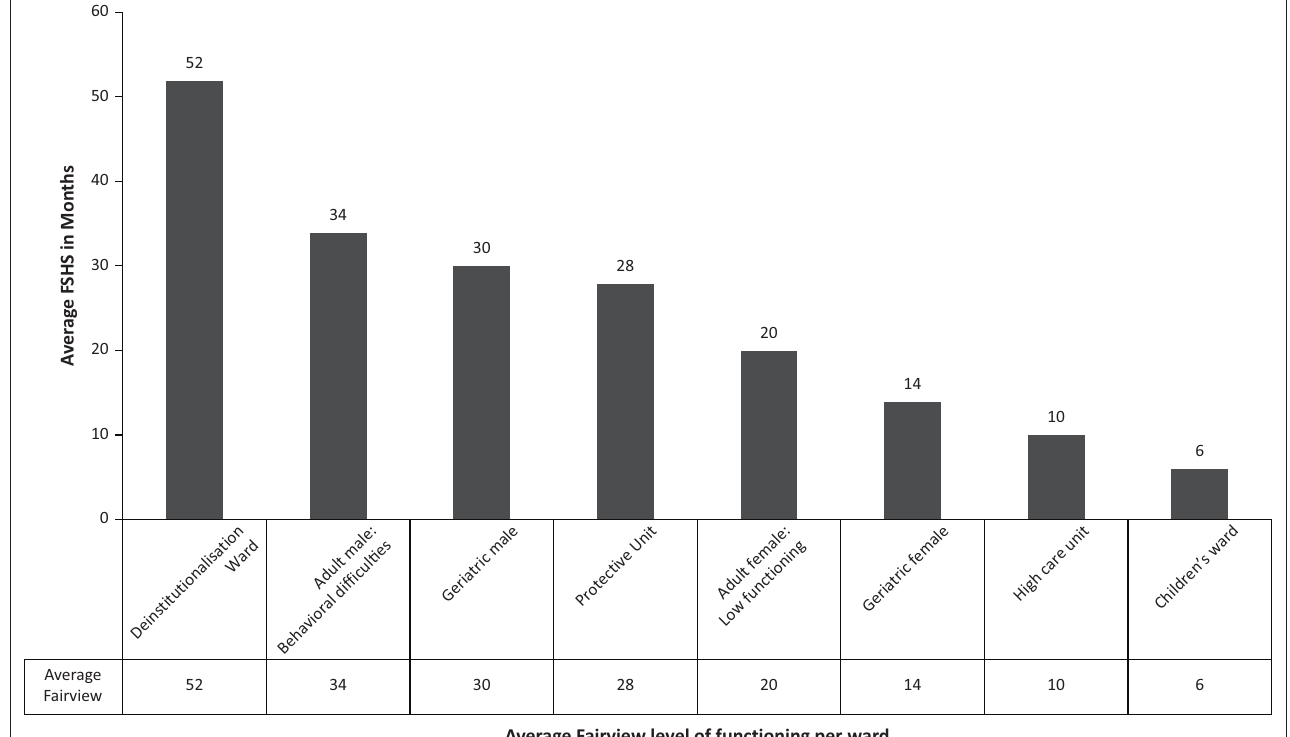
FIGURE 2: Average Fairview of functioning per TABLE 4: Spearman’s rank order correlations between creative ability and adaptive functioning. Pair of variables Spearman’s rank order correlations (Witrand patient stats) MD pairwise deleted Marked correlations are significant at p < 0.05000 Valid N t(N-2)